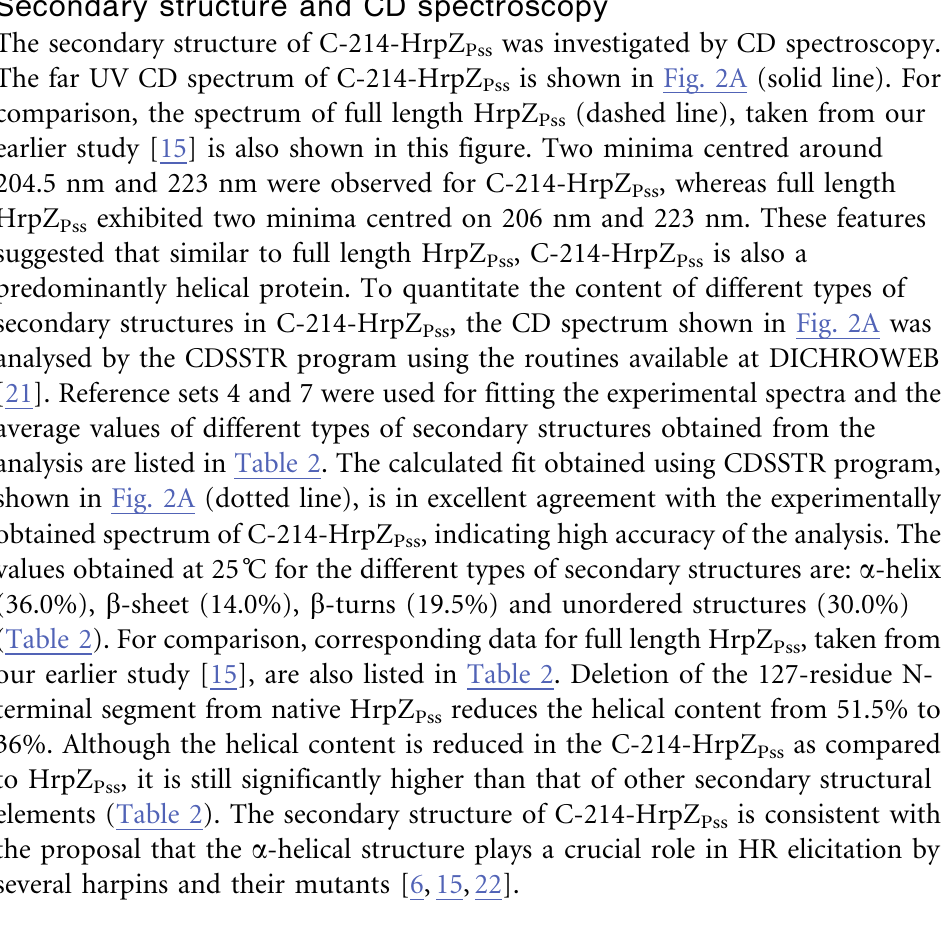
Values given are averages obtained from 3 independent measurements. Values in parentheses correspond to the thermal unfolding of full length HrpZ Pss [15]. *C-214-HrpZ Pss does not have transition